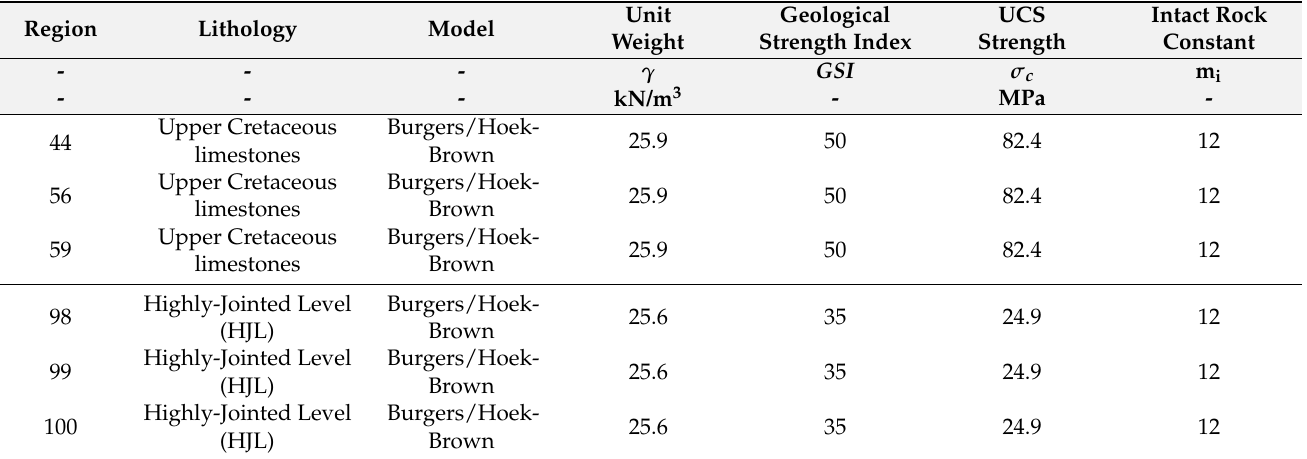
Table 3. Synthesis of physical and strength parameters used for the rock mass. In this table, only the characteristics of the regions directly involved in DSGSD are reported. For location of different regions, please refer to Figure